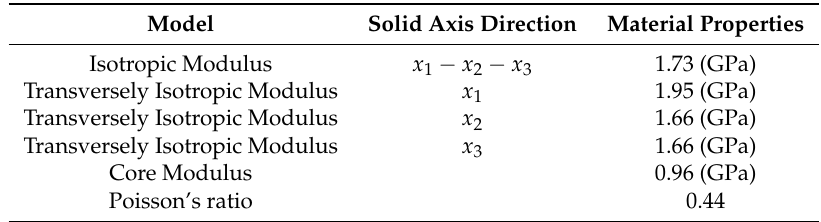
Table 3. Modulus values from micromechanical predictions used in FEA modeling.